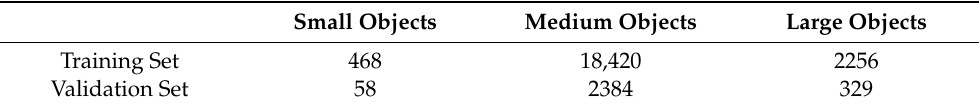
Figure 1. Objects’ size scatter of the dataset: red triangle represents the pixel size in the most concentrated rural buildings: ( a ) Training set; ( b ) Validation set. Table 2. Rural buildings size statistics in